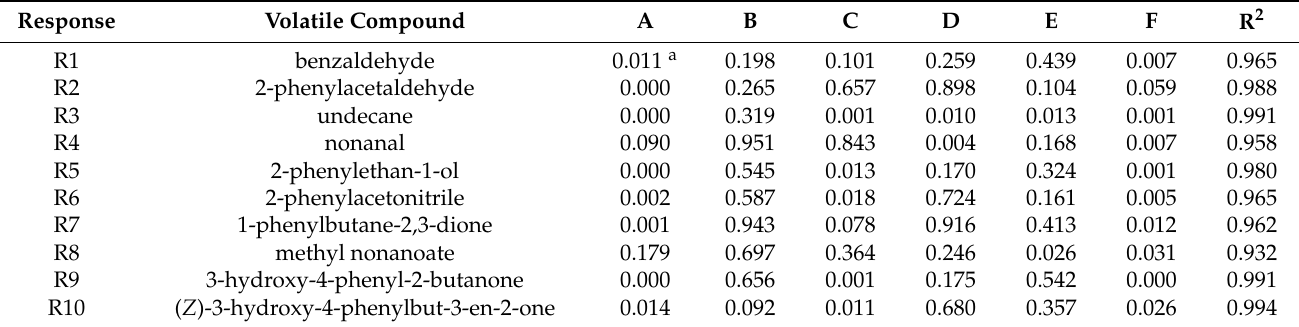
Table 4. Coefficients and R 2 of each response subjected to the